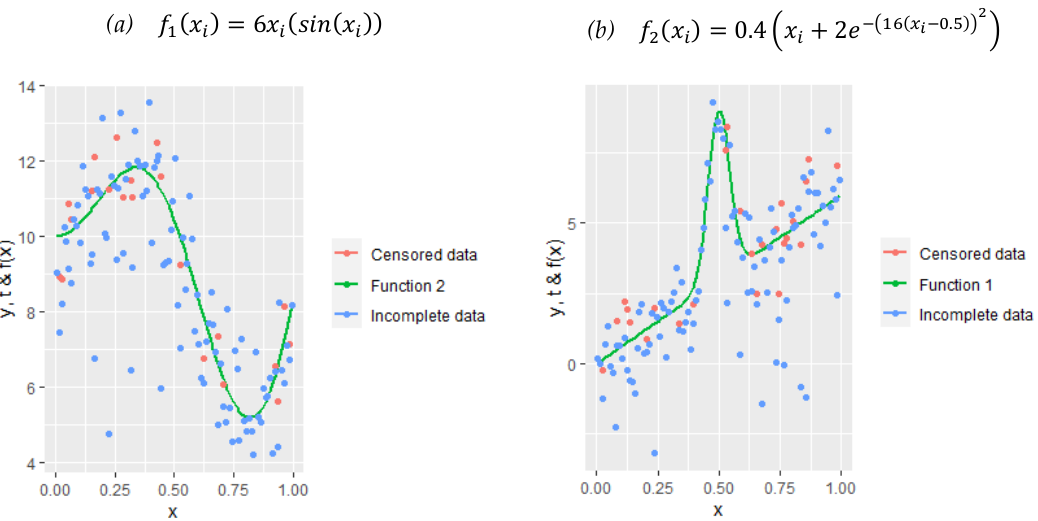
Figure 1. Scatter plots of both censored data and incomplete response data points over the smooth functions to be estimated by A-splines.